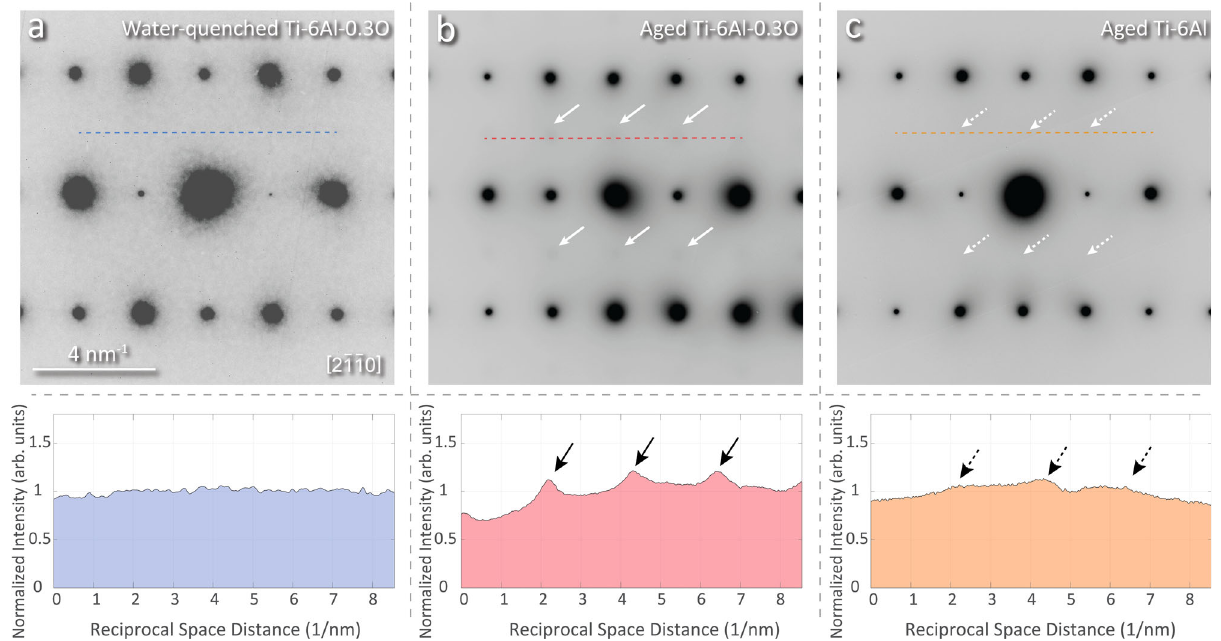
(cid:2) (cid:3) diffraction pattern of a water-quenched Ti-6Al-